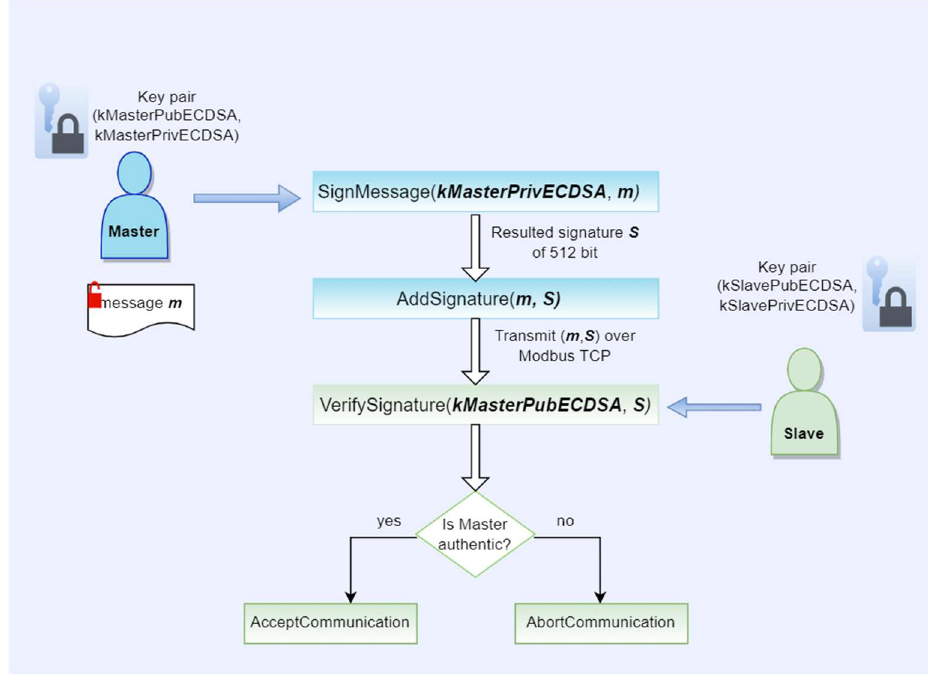
Figure 2. ECDSA authentication scheme.